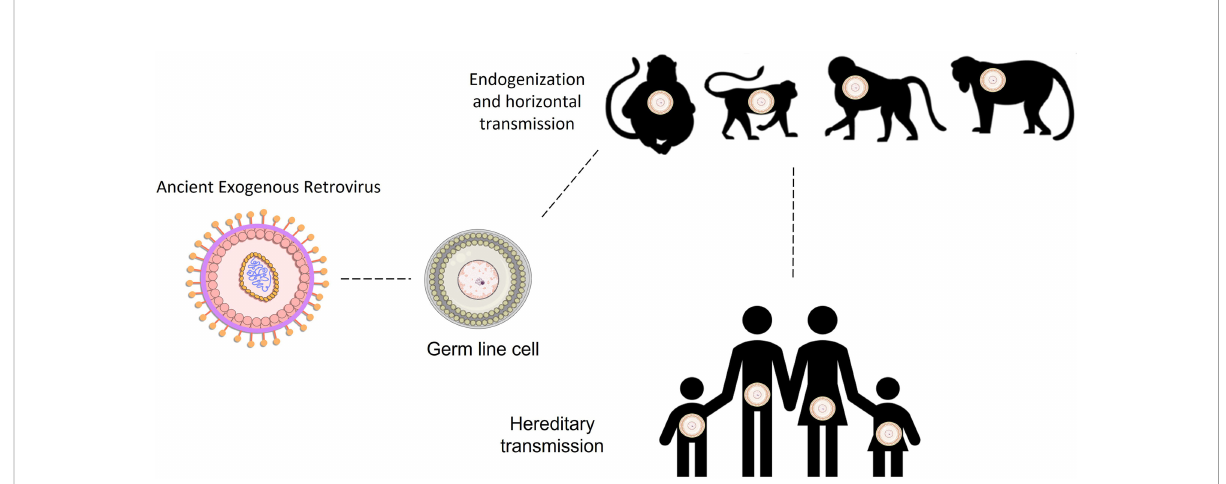
FIGURE 1 Human endogenous retroviral integration and transmission throughout host evolution of primates and humans. HERVs families were integrated into the hominid ancestral genomes in several distinct times throughout the human evolution. Draw lines between primates and human demonstrate the time between the integration moment and the present